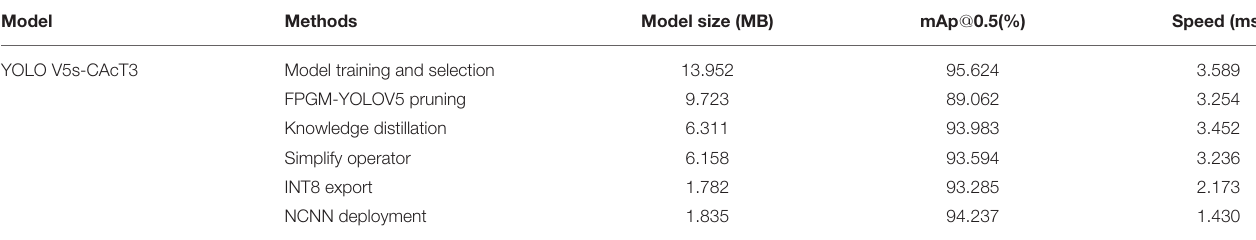
TABLE 11 | Deployment performance